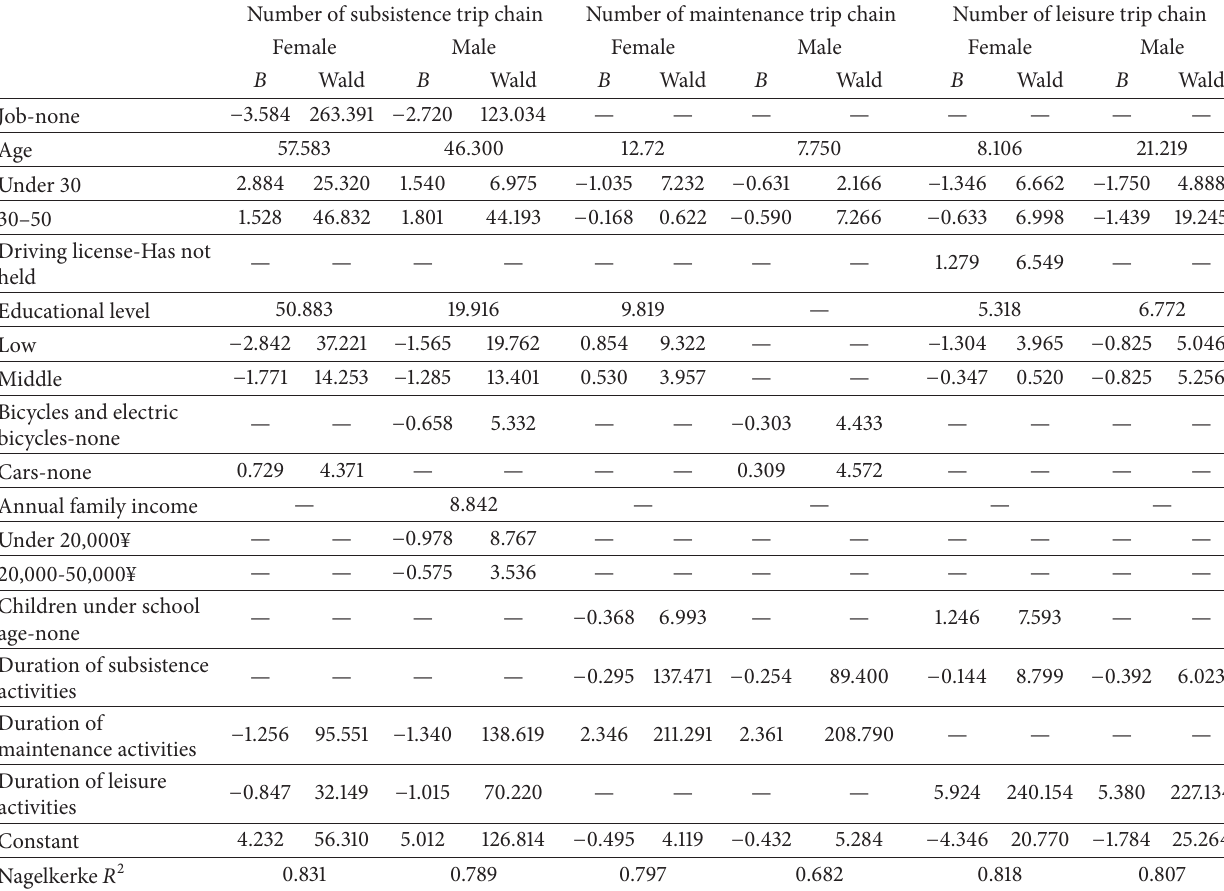
Table 4: Binary logistic regressions for number of subsistence, maintenance, and leisure trip